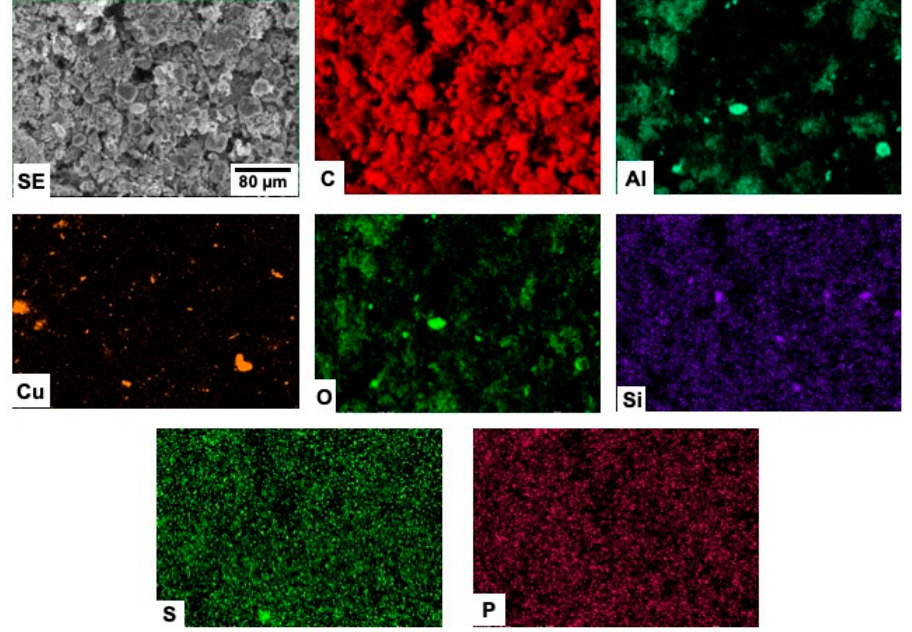
Figure 7. SEM-EDX mappings from sample C-L 2 BM.